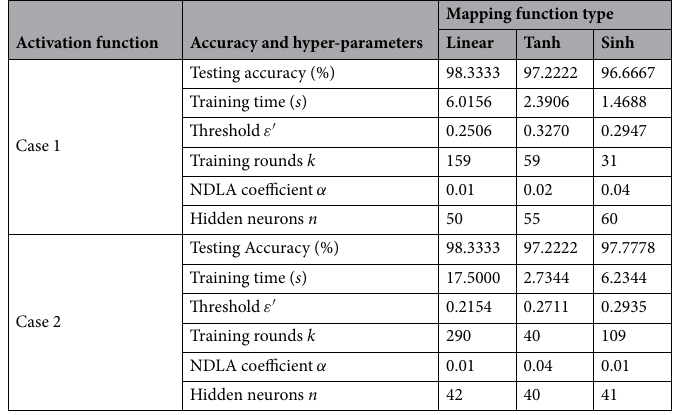
Table 3. Accuracies and hyper-parameters of single dynamic learning networks.